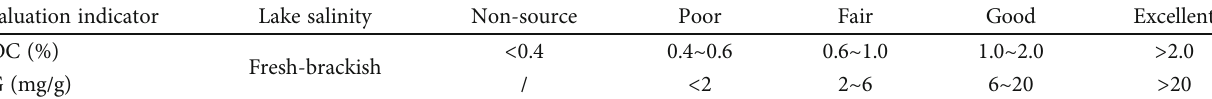
Table 1: Evaluation index of organic matter abundance of continental source rocks